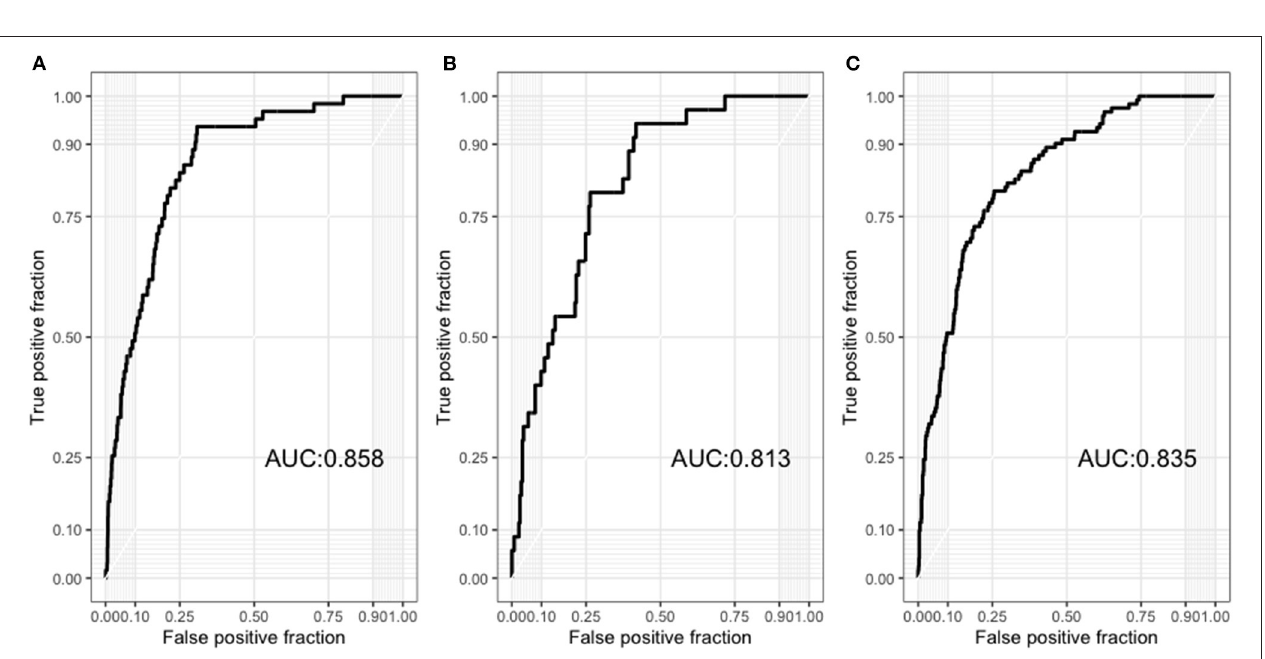
FIGURE 5 | (A) Receiver operating characteristic curves of the results from our model to predict 5-year all-cause mortality among patients with acute coronary syndrome. (B) Receiver operating characteristic curves of the results from our model to predict 5-year all-cause mortality among patients with chronic coronary syndrome. (C) Receiver operating characteristic curves of the results from our model to predict 5-year cardiovascular mortality in all patients.